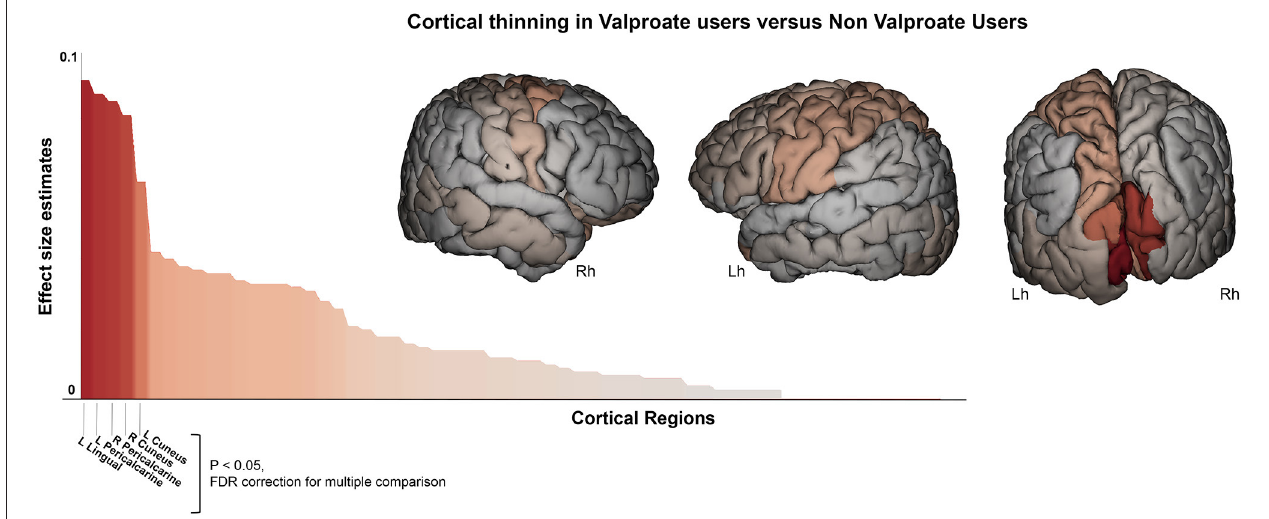
FIGURE 2 | Cortical thickness difference between valproate users and non-valproate users. Surface brain template showing regions of cortical thinning in valproate users compared to non-valproate users. Brain images are generated using EnigmaViewer (https://www.nitrc.org/projects/enigmaviewer_20/); strength (color) of heat map is determined by the size of the regional effect size estimate. Effect size estimates (partial eta squared, y-axis) for cortical thickness differences across all brain regions is showed on the bar plots. Brain regions with significant differences between groups ( p < 0.05 FDR; ANCOVA analysis adjusted for age, sex, disease duration, and intracranial volume) are reported on the x-axis. Lh, left hemisphere; Rh, right hemisphere.